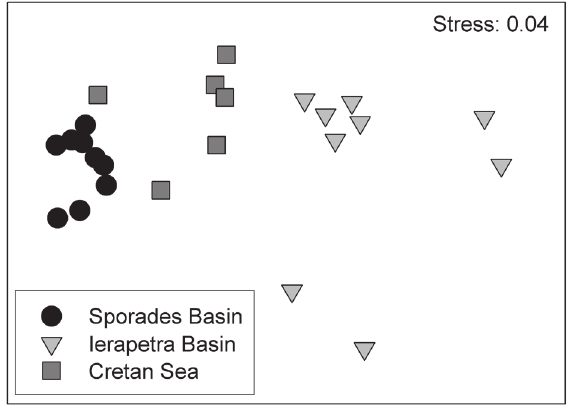
Fig . 4. – Non-parametric multidimensional scaling (mds) ordina- tion of replicate samples from the three sapling areas.